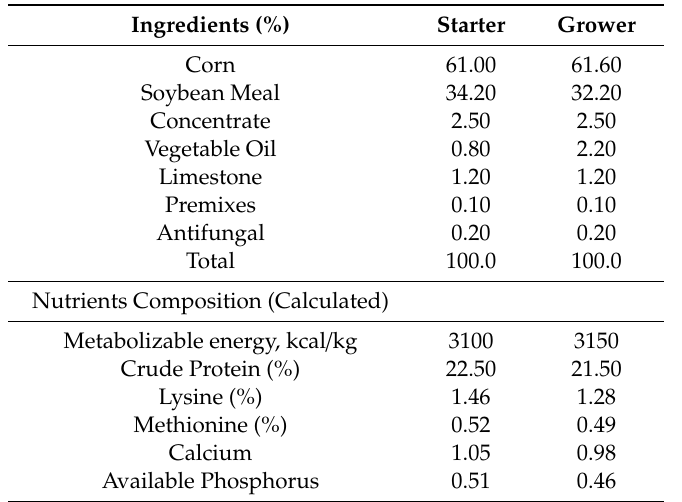
Table 1. Ingredients and chemical composition of basal experimental